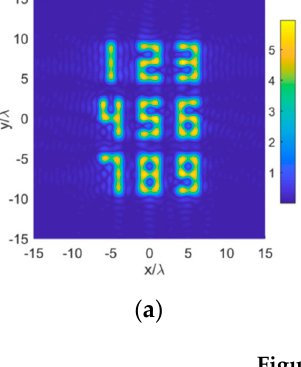
Figure 14. Reconstructed results for Case 3. Sampling on a plane grid. Only propagation modes within θ s ,max = 30 ◦ are used. ( a ) No noise; ( b ) SNR = 20 dB WGN; ( c ) SNR = 0 dB